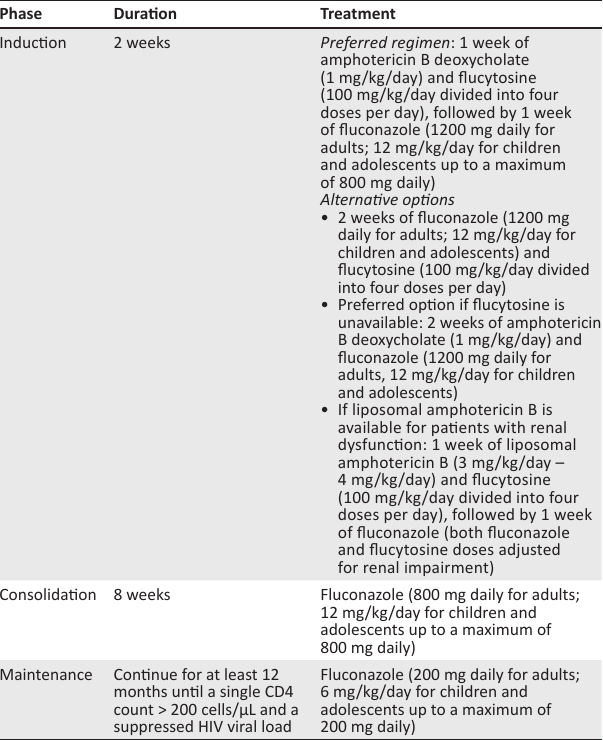
TABLE 3: Summary of recommendation